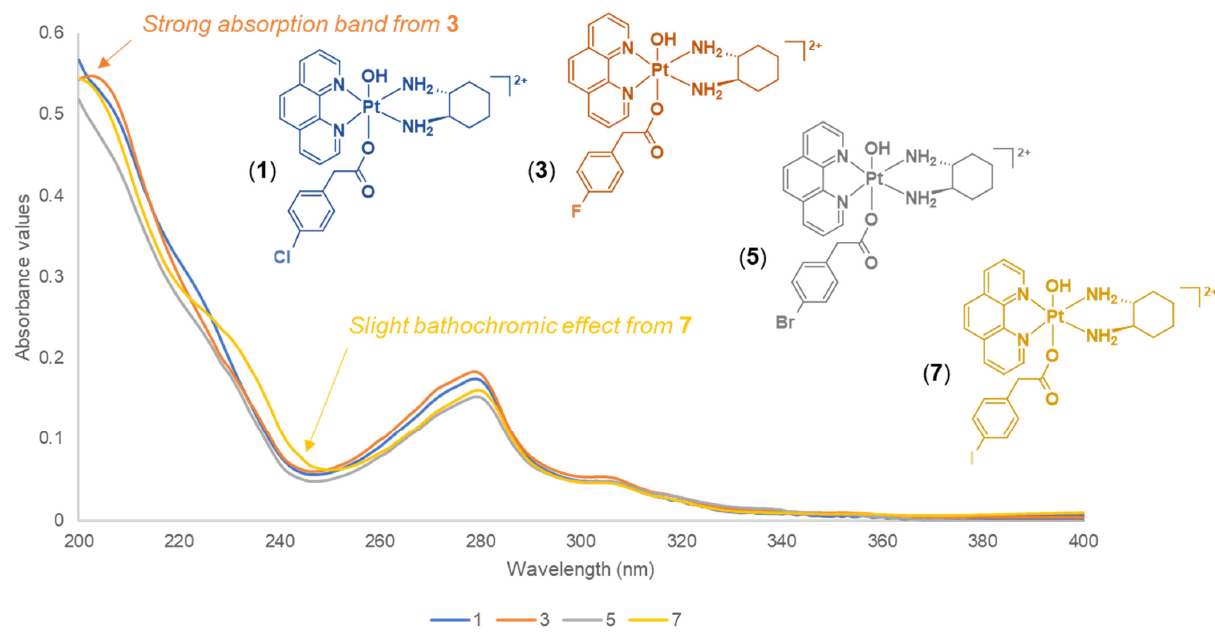
Figure 13. Stacked UV spectra of phen derivatives, 1 , 3 , 5 , and 7 , obtained at 298 K, showing UV absorptions at different wavelengths. Inset: colour-coded structures of 1 , 3 , 5 and 7 .